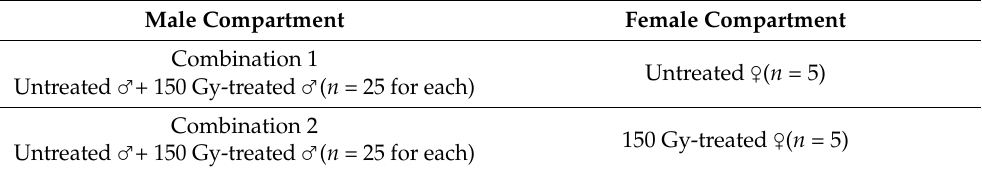
Table 1. Combinations of Lobesia botrana male and female moths in the experimental flight